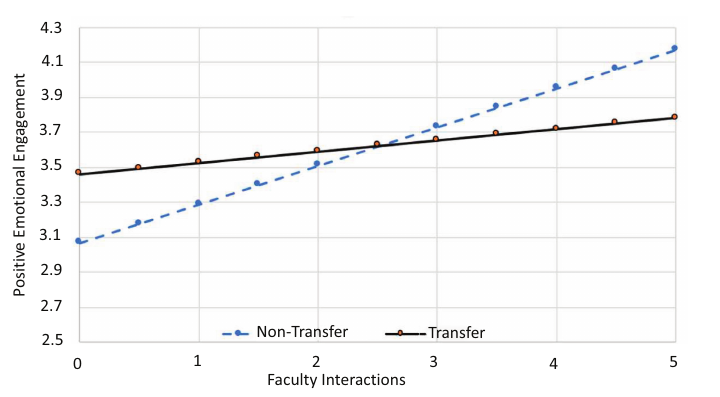
Table 8. Hierarchical regression models for positive emotional engagement